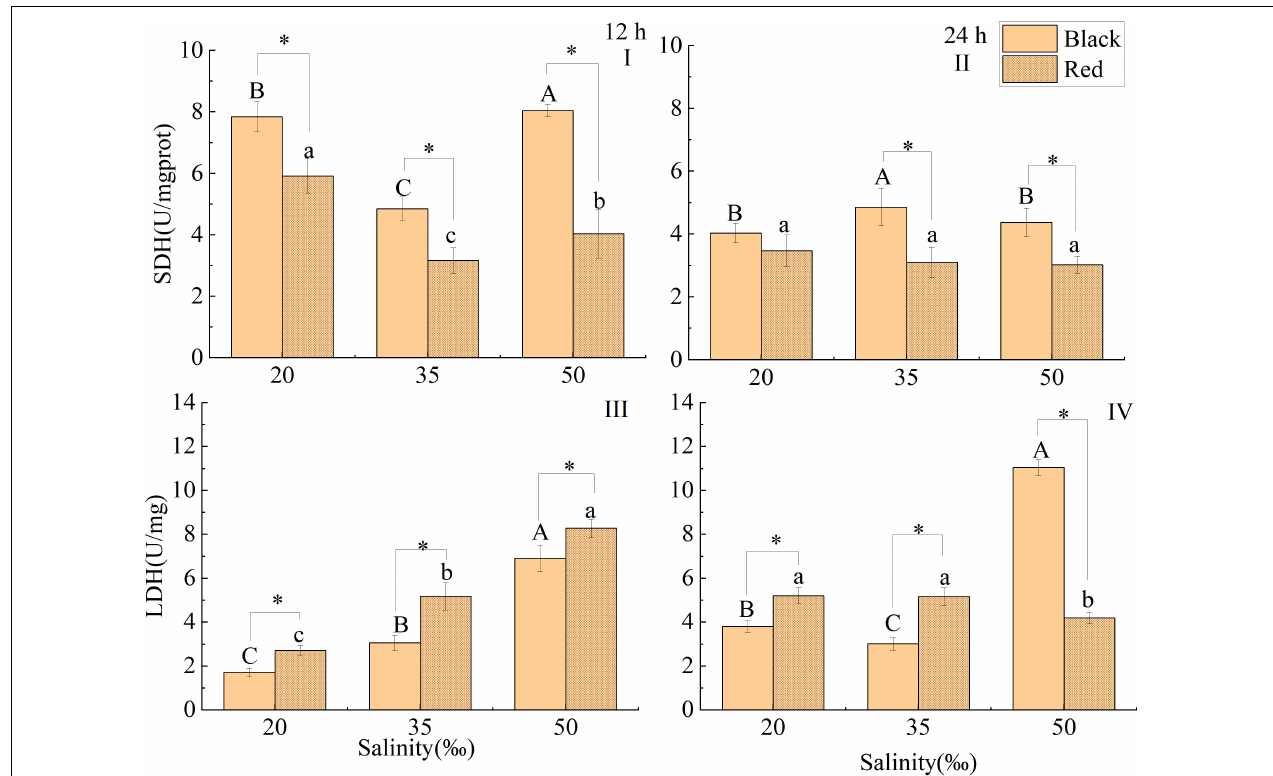
FIGURE 5 | Effects of salinity on SDH and LDH activities in the gill tissue of P. fucata with two shell colors (I: 12h, SDH activity; II: 24h, SDH activity; III: 12h, LDH activity; IV: 24h, LDH